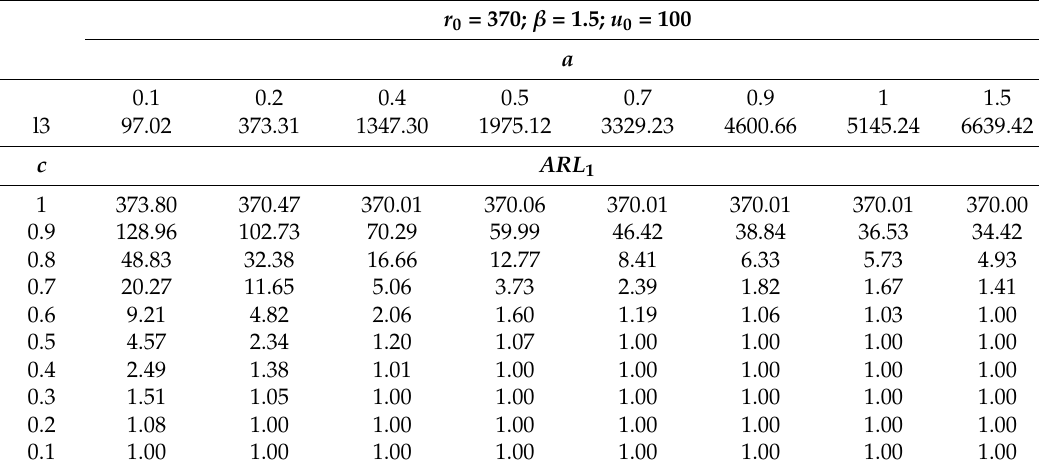
Table 8. The values of ARLs when r 0 = 370, β = 2, and µ 0 = 100.